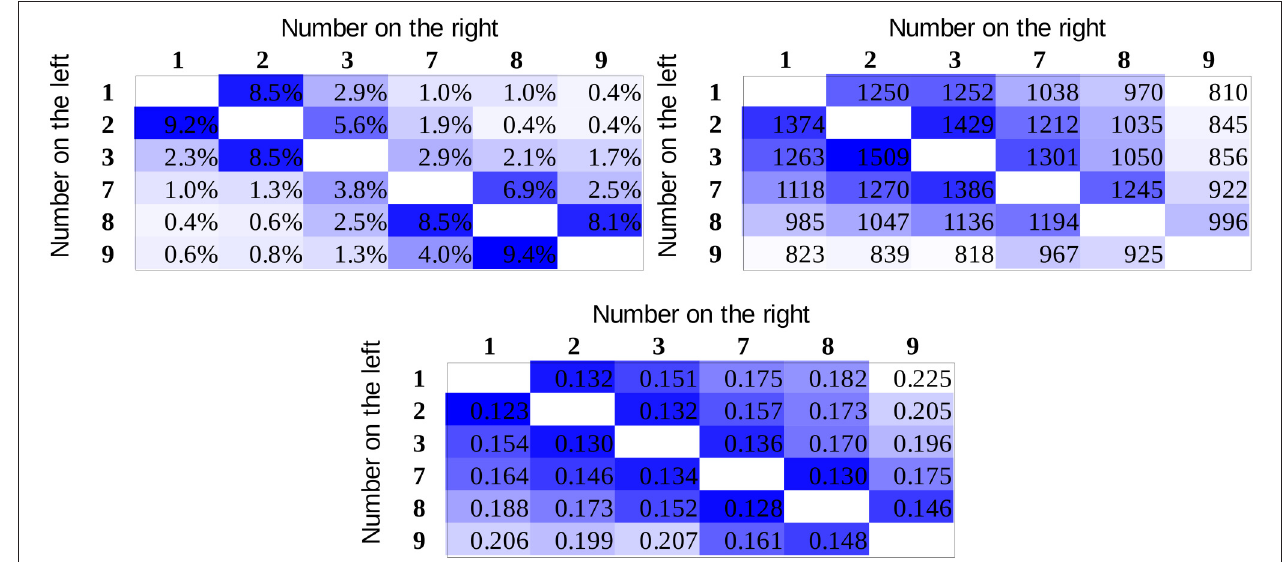
FIGURE 6 | Error rates (top left) , reaction times (in ms, top right ), and drift rates (bottom) in the whole stimulus space in the replication study.